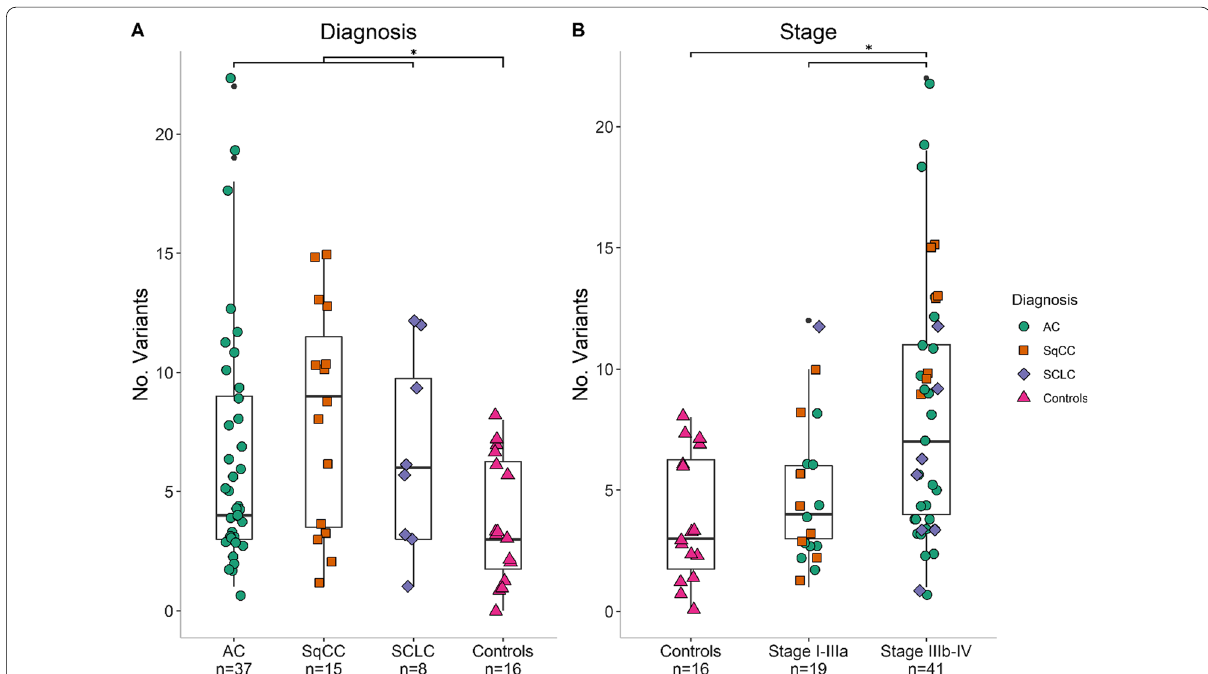
Fig. 2 Number of variants detected in plasma cfDNA. A Number of variants in plasma separated on diagnosis. Controls consisted of patients referred to the lung clinic with the suspicion of lung cancer but later diagnosed with different benign lung diseases. B Number of variants in plasma separated on stage. AC adenocarcinoma, SqCC squamous cell carcinoma, SCLC small cell lung cancer